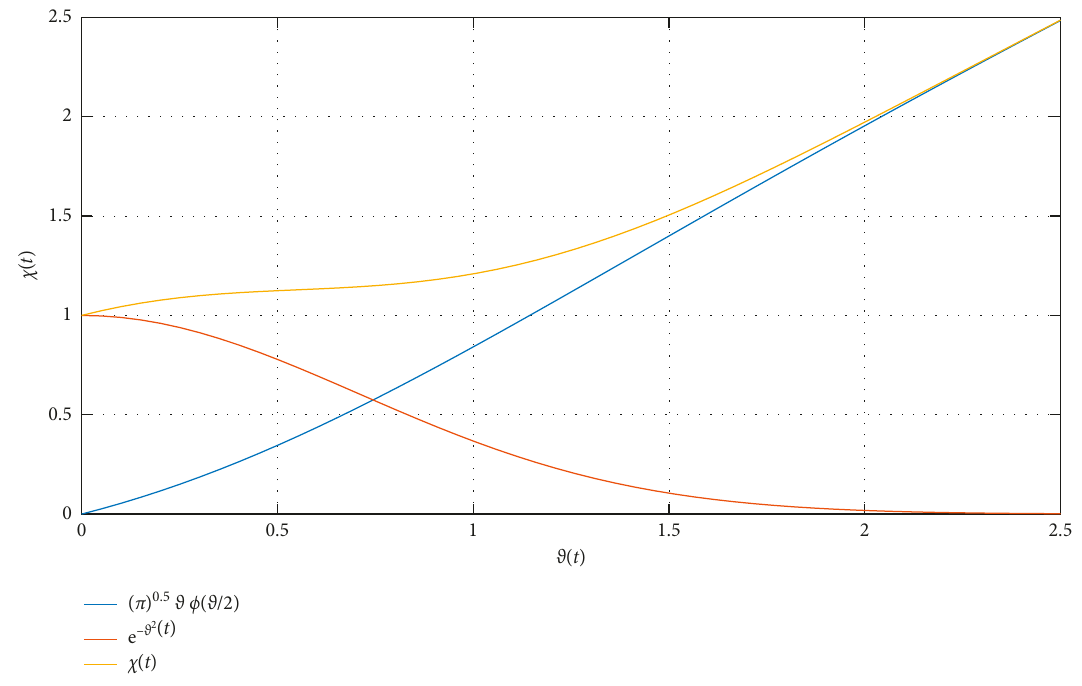
Figure 1: Factor χ .